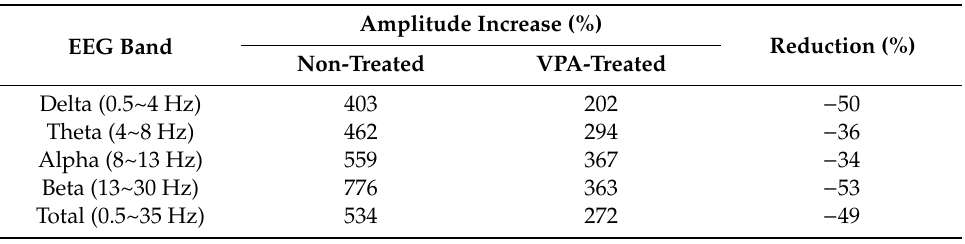
Table 1. Amplitude increase by PTZ in both non-treated and VPA-treated groups, according to frequency bands, and resultant amplitude reduction by VPA